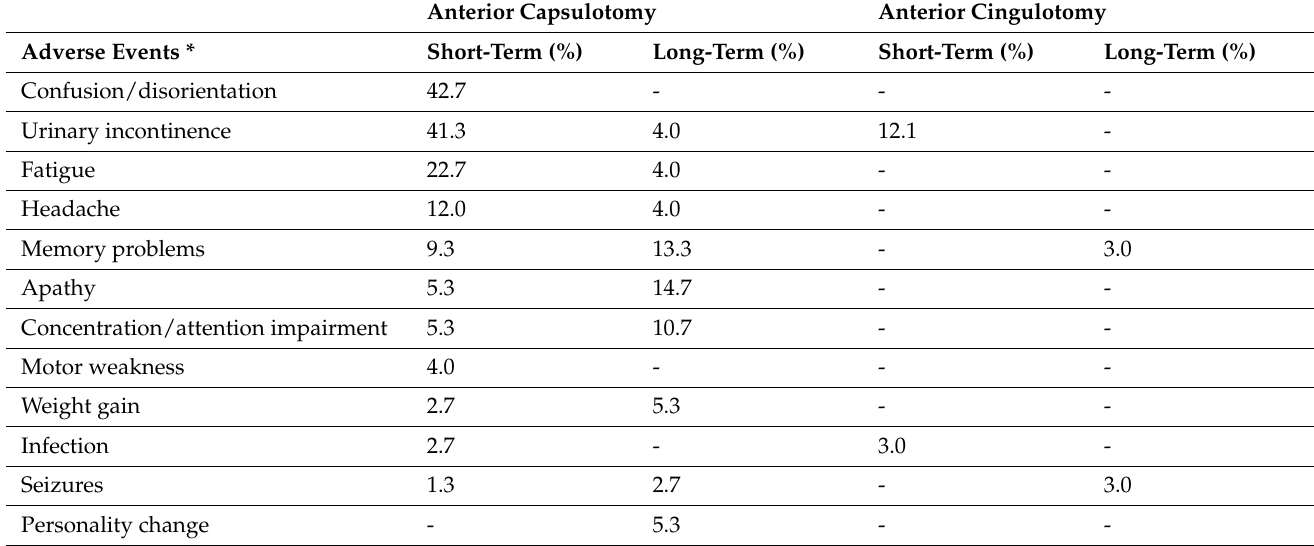
Table 2. Most frequently reported adverse events across all selected studies ( n = 108). Short-term is defined as persisting less than 12 months, whereas long-term as persisting more than 12 months. * No data regarding adverse events were available for Steele et al. [18]. Anterior Capsulotomy Anterior